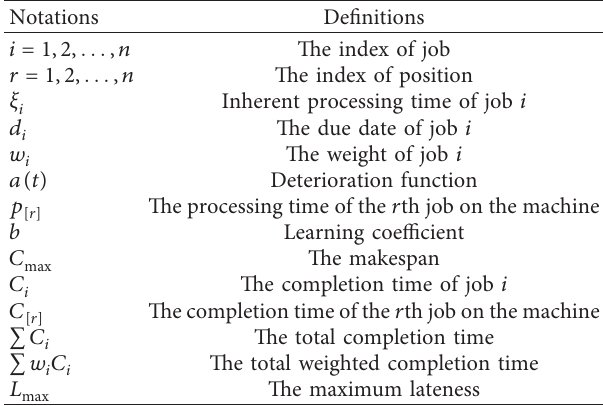
Table 1: List of